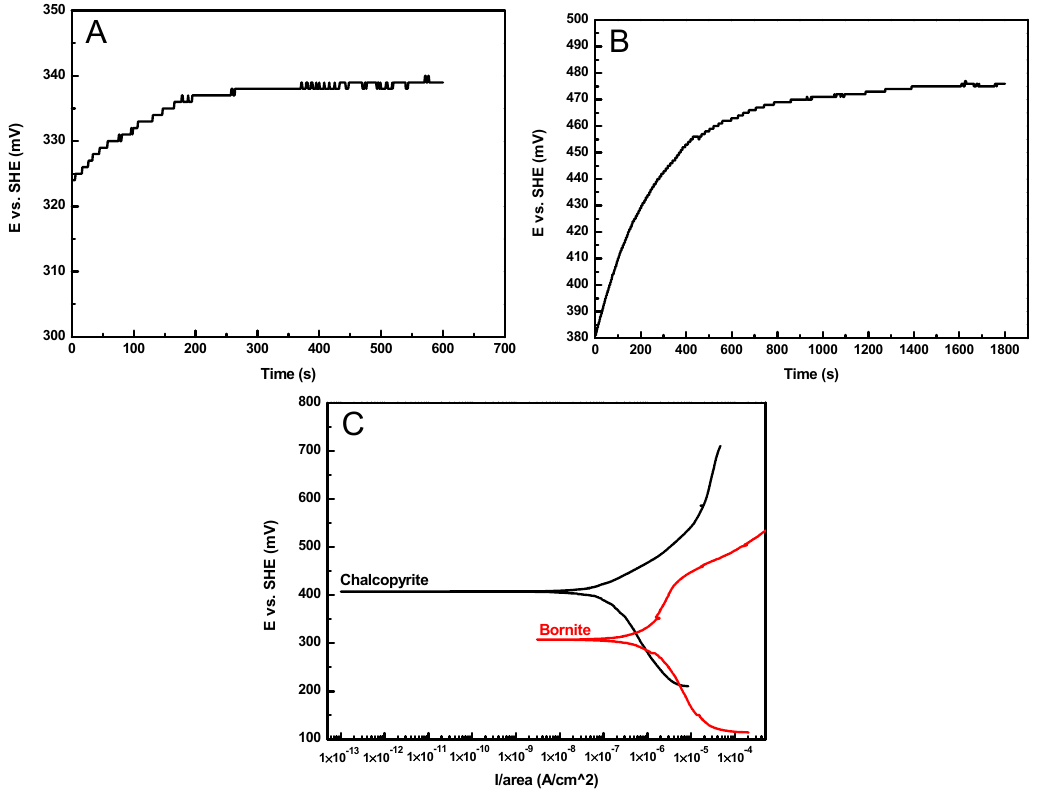
Figure 8. Open-circuit potential of massive bornite ( A ) and chalcopyrite ( B ) electrode. Tafel plot for chalcopyrite and bornite electrode ( C ).